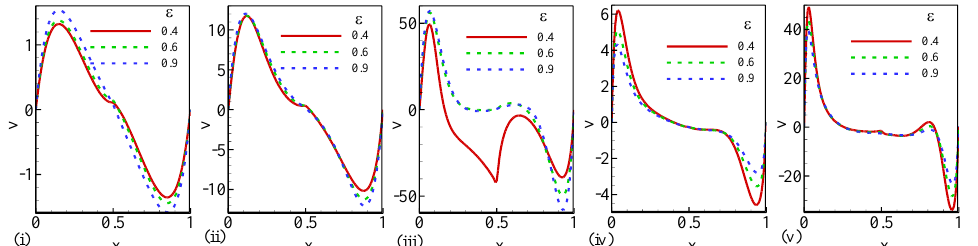
Fig. 7 (a). Effect of porosity parameters on normalized v velocity of horizontal porous layer at (i) Ra =10 3 , Da =10 -2 , (ii) Ra =10 4 , Da =10 -2 . (iii) Ra =10 5 , Da =10 -2 , (iv) Ra =10 5 , Da =10 -4 and (v) Ra =10 6 , Da =10 -4 .